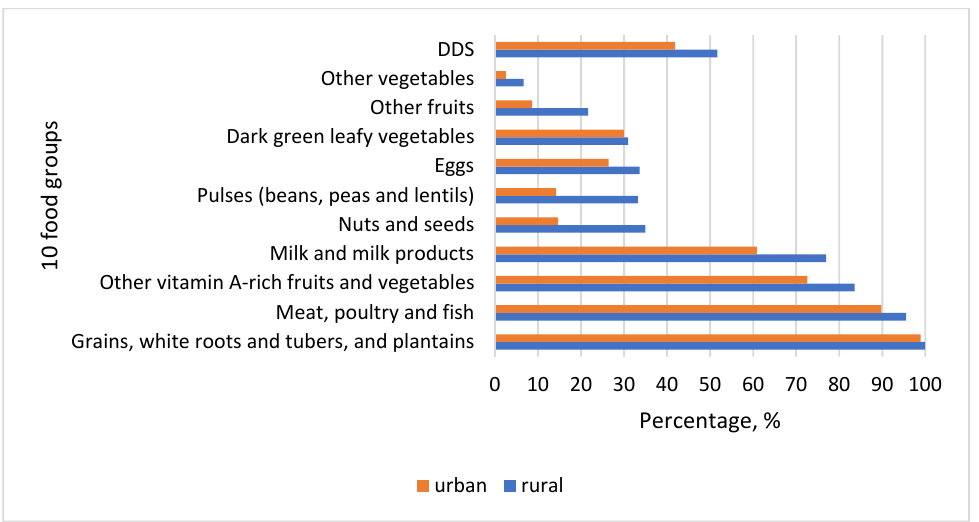
Figure 3. Consumption of ten food groups among women of reproductive age (WRA), and dietary diversity score (DDS) in rural and urban